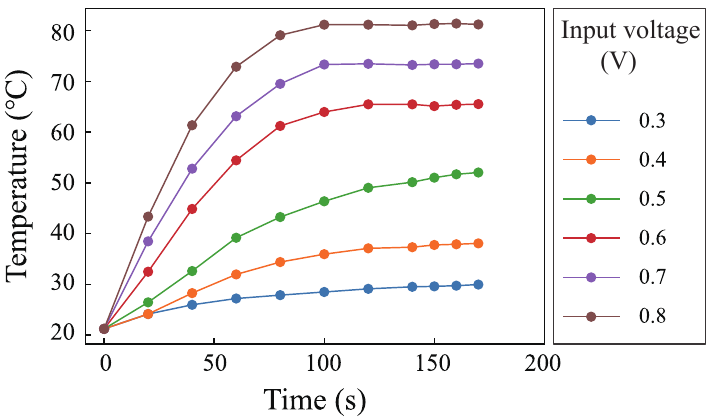
Figure 5. The RhB luminescent intensity pictures with time of (a) 0 s, (b) 20 s, (c) 40 s, (d) 60 s, (e) 80 s, (f) 100 s when the input voltage was 0.7 V. The bar is 100 µ m. 140 The flow rate is an important parameter in microfluidics. It is important to mea- 141